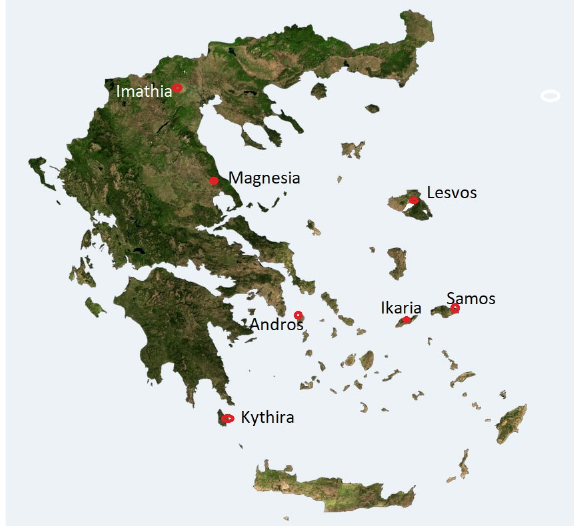
Figure 1. Geographic locations of the prospected plant material. Table 1. Name, location, flesh type and flesh color in 32 local peach cultivars/accessions prospected from various areas in Greece, and 13 old foreign peach cultivars grown in an ex situ collection. MPE, melting peach; NMPE, non − melting peach; NE, nectarine; YE, yellow; W, white.